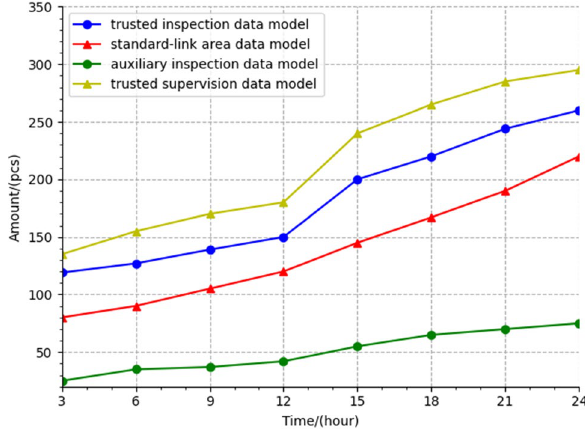
Figure 11. Analysis of trusted data sources.